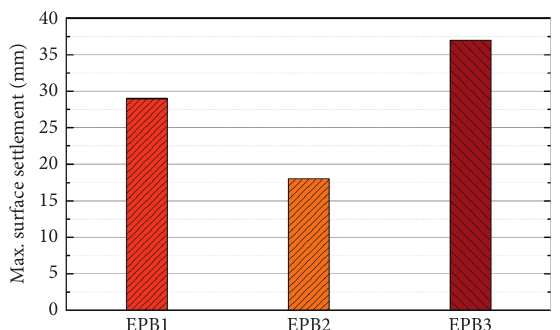
Figure 12: The maximum surface settlements of the EPBs.